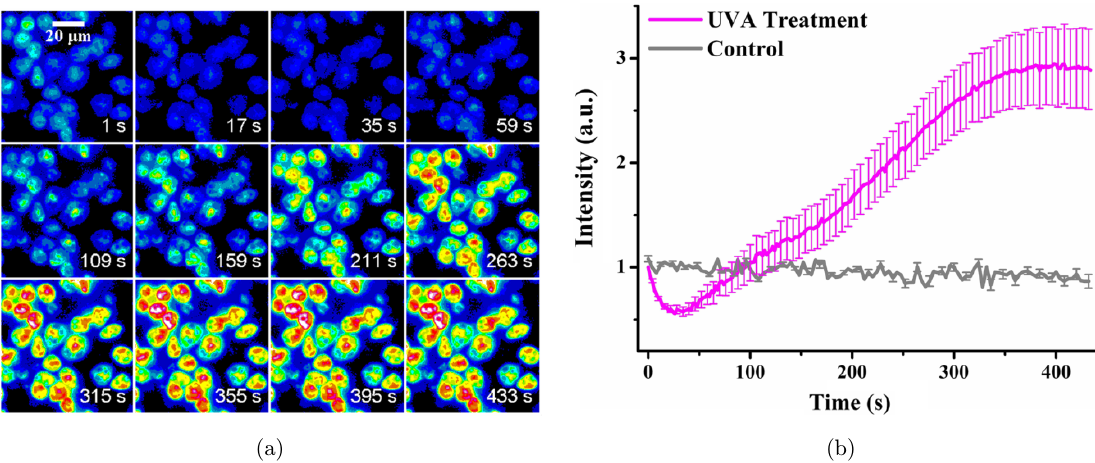
Fig. 5. UVA irradiation induced an increase in NADPH in neutrophils. (a) Typical NAD(P)H °uorescence images of human neutrophils excited by 365 nm UVA at 2.27 W/cm 2 . The color range was divided in the spectral sequence from high intensity (white) to low intensity (black). (b) Tracings of NADPH °uorescence elevation in the presence or absence of UVA treatment. Statistical data are presented as the means (cid:4) SD ( n ¼